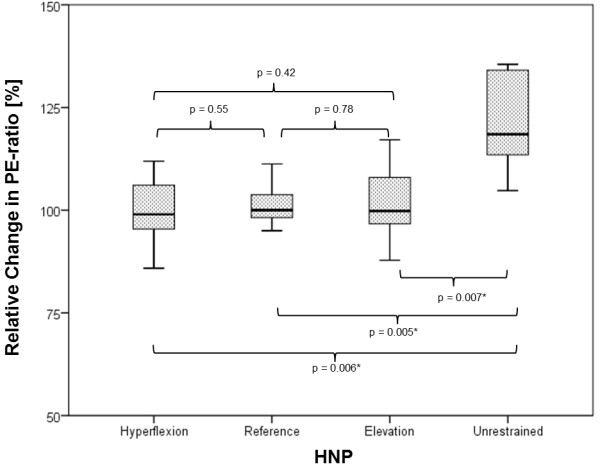
Percentage change in PE-ratio as a function of the head and neck positions (hyperflexion, reference, elevation and unrestrained). There was a significant difference (p < 0.01) between the relative change in PE-ratio in the unrestrained head-neck position and the other contact positions investigated. The boxes defined the upper and lower quartiles with the medians marked by the horizontal lines, the whiskers indicated the minimum and maximum values (n = 40).